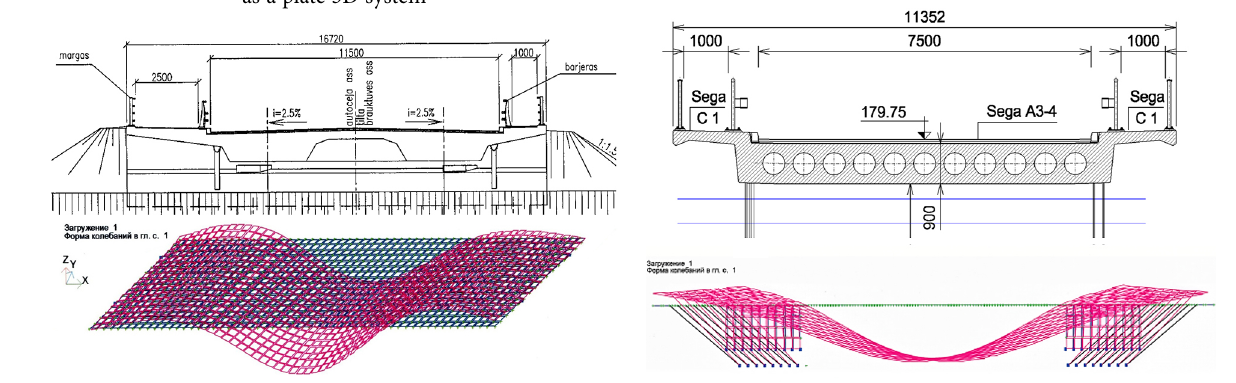
Fig. 14. Cross section and first mode shape of a bridge over river Gauja on Road V235. FE model constructed as a plate-strut 3D